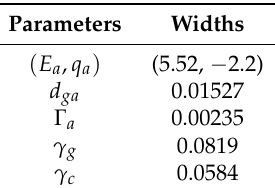
Table 1. Atomic parameters in a.u. used for the Li + ( 2 s 2 p ) AIS